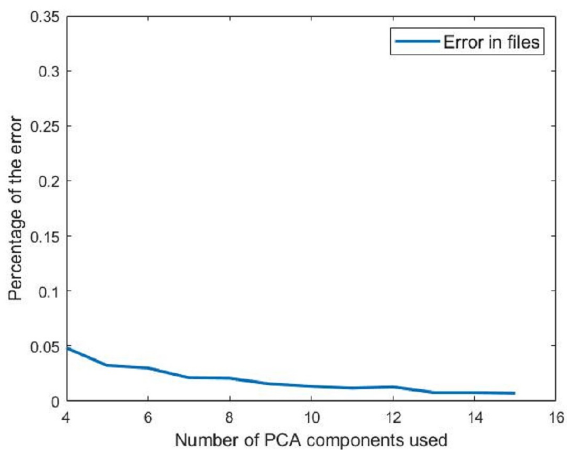
Figure 12. The percentage of activities that could not be segmented.